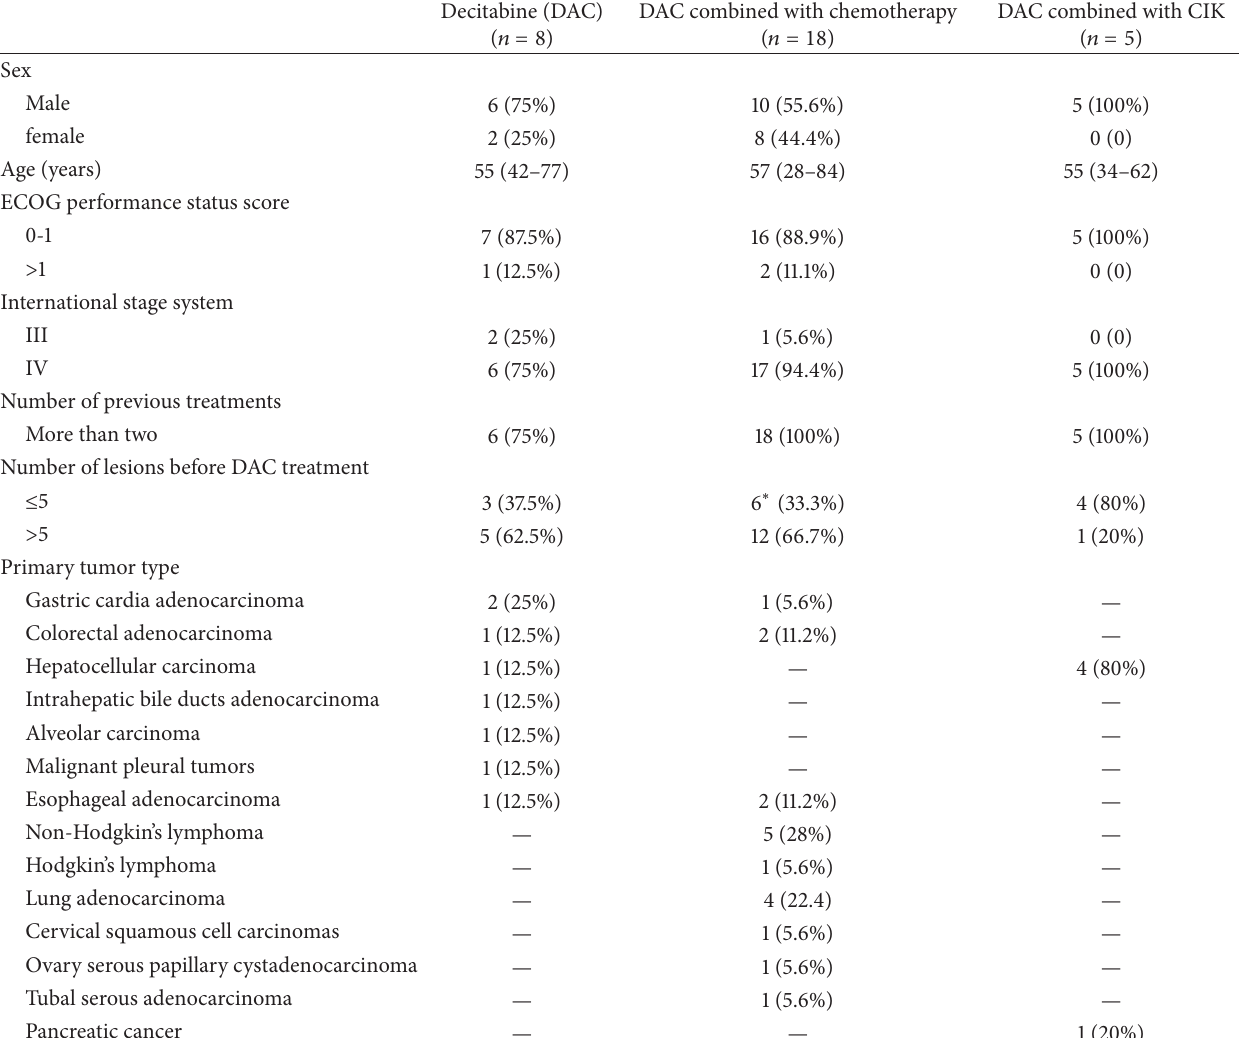
Table 1: Baseline characteristics of